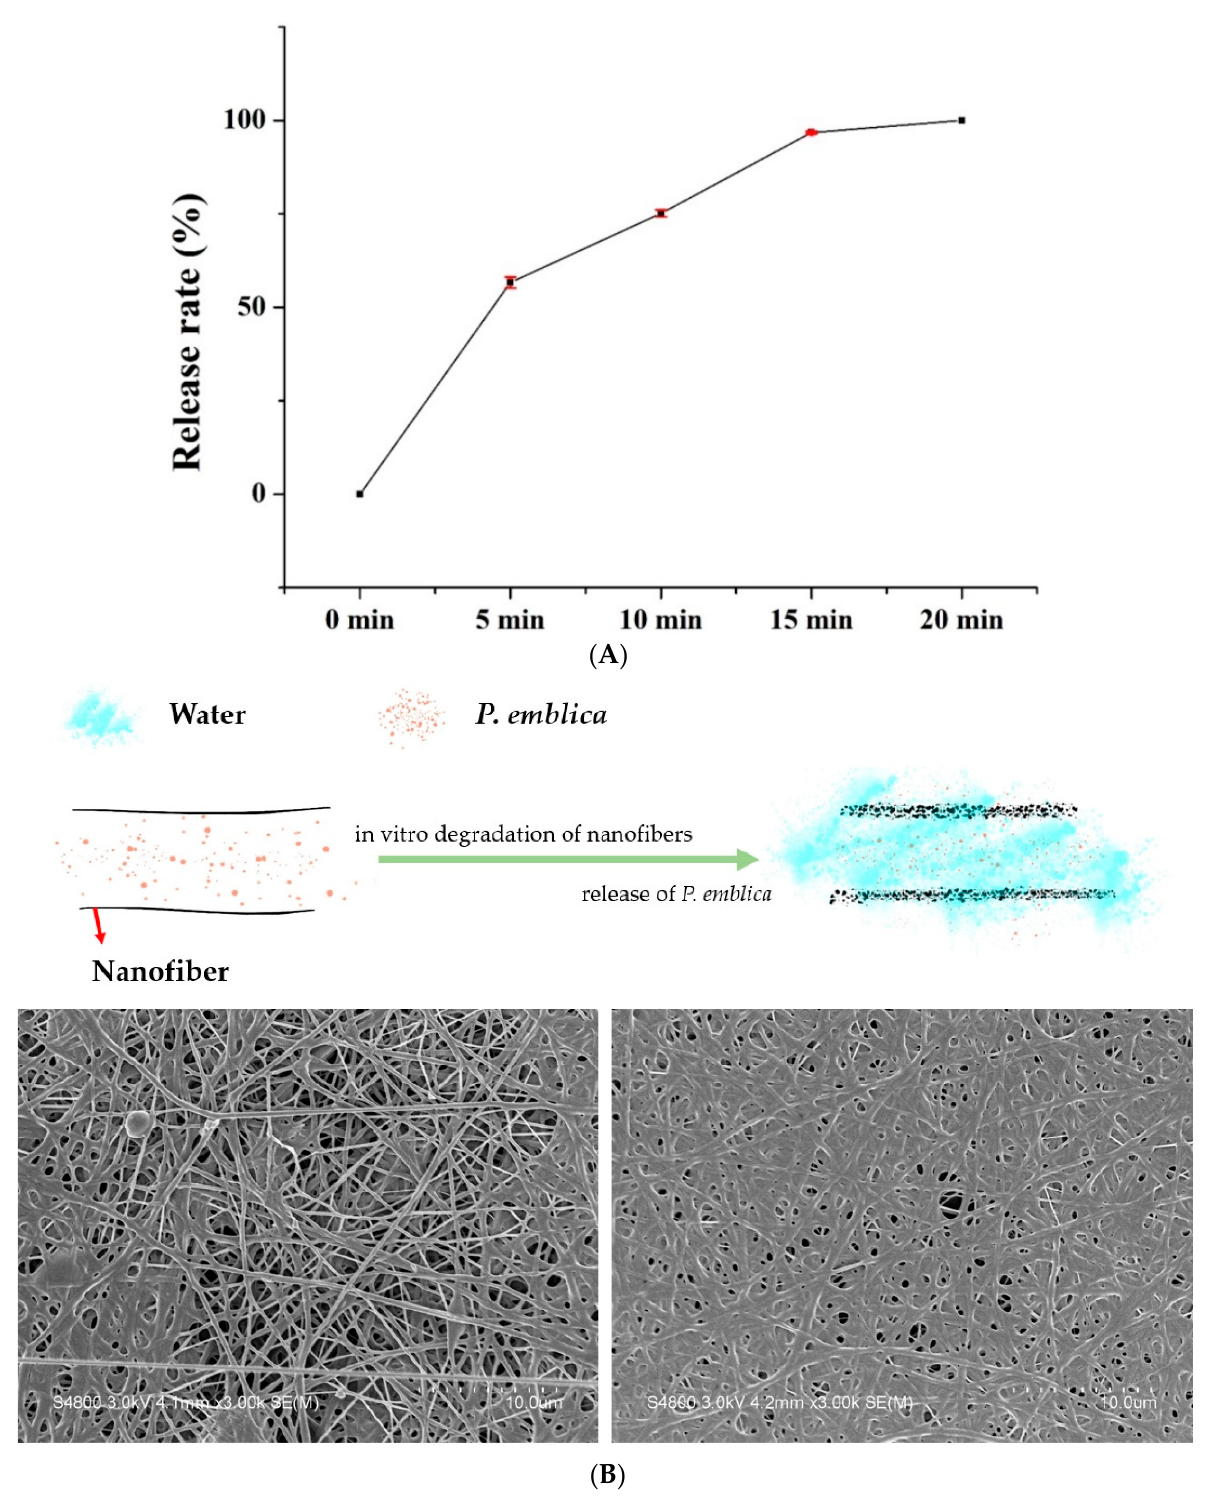
Figure 7. ( A ) Release rate of nanofiber membranes as related to the time and ( B ) SEM images of the releasing process and degrading process.